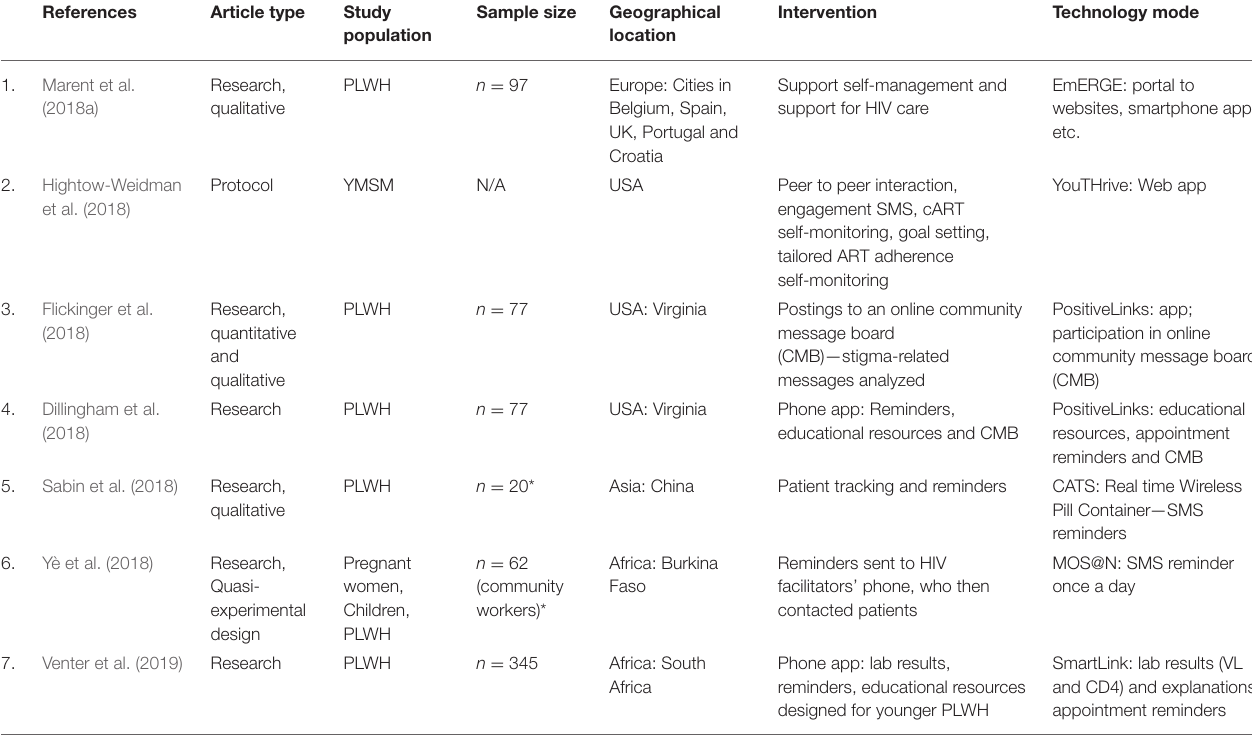
TABLE 1 | Summary of article type, study population, geographical location, intervention, and technology mode for mHealth articles published January 2017–June 2019 that met inclusion